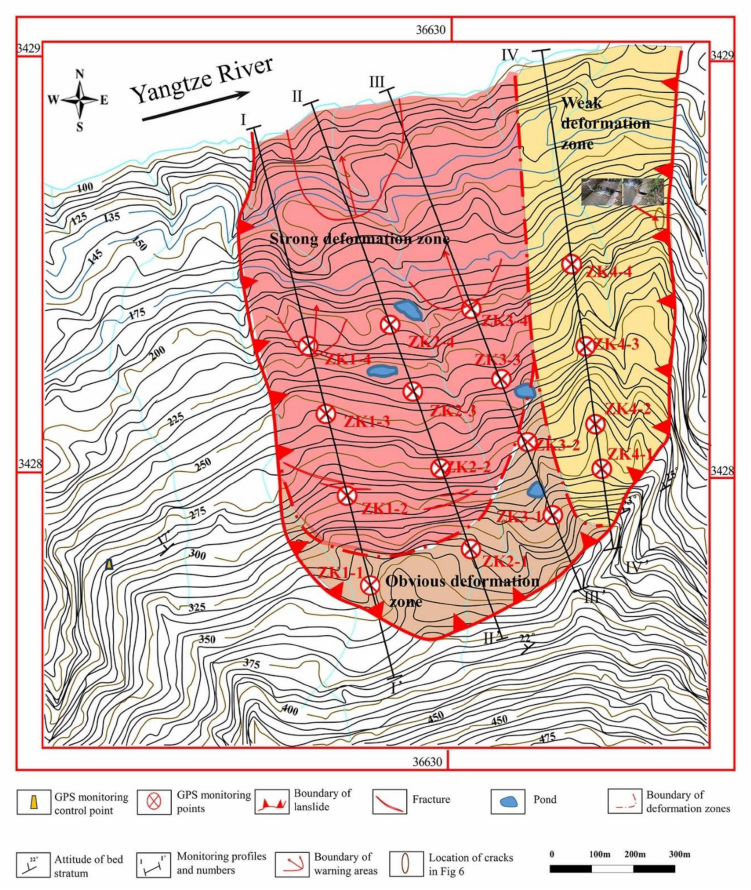
Figure 5. Monitoring arrangement in the Shengjibao landslide and displacement blocks.